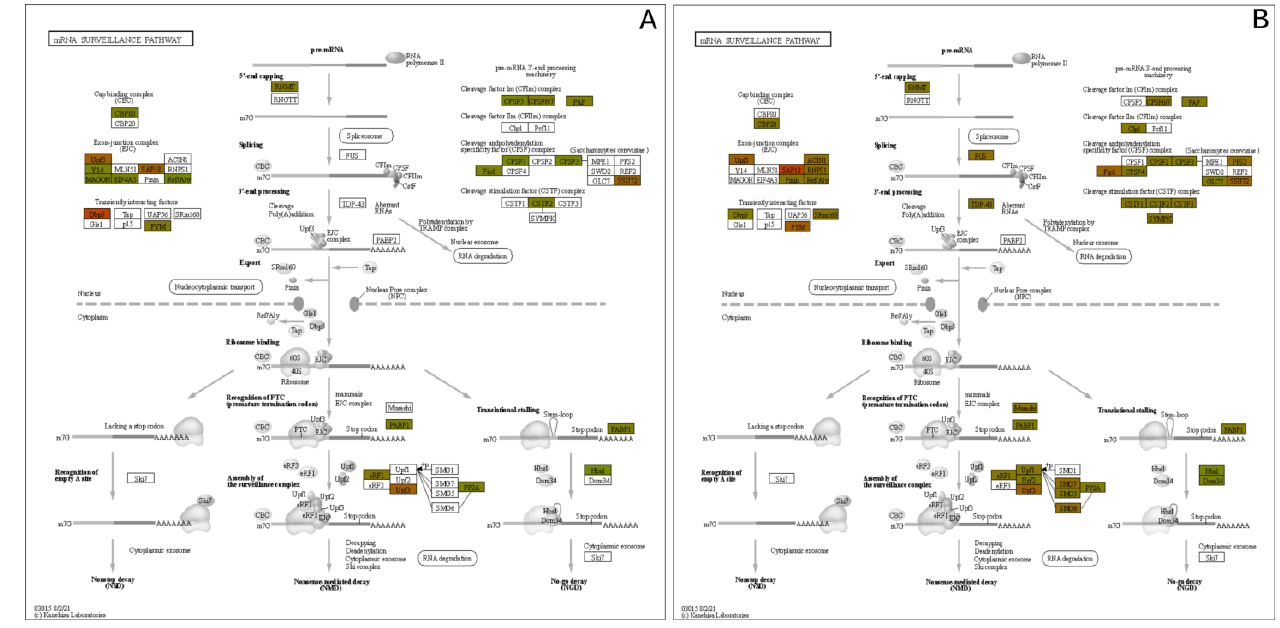
Figure 9. mRNA Surveillance pathway expression mapping at the ( A ) 3 h and ( B ) 24 h post exposure levels.